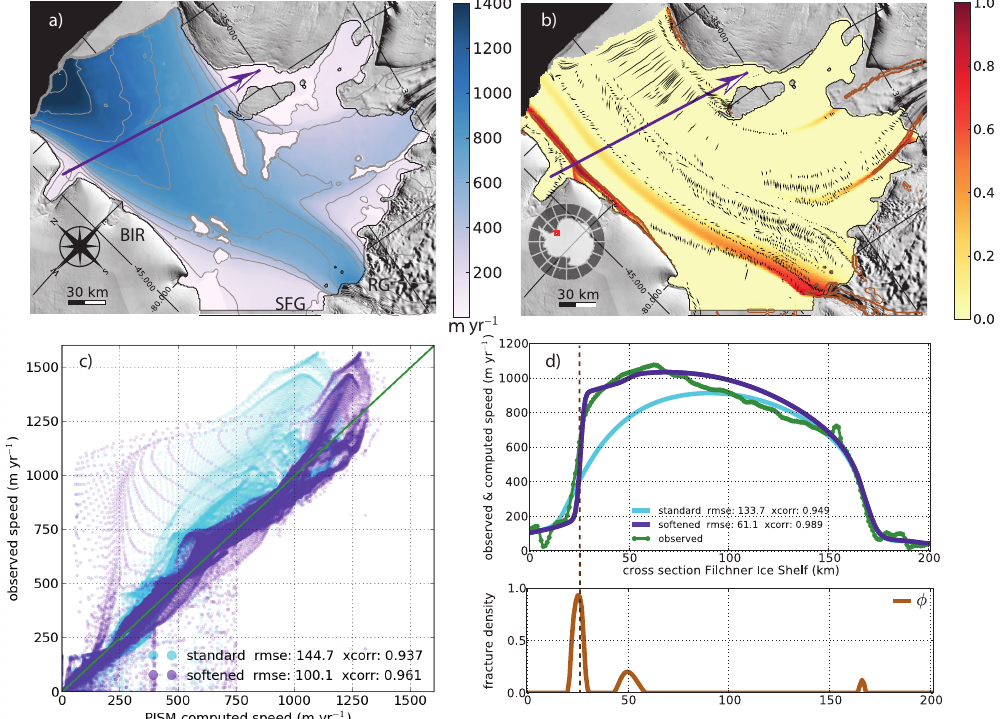
Fig. 10. Observed surface speed over MODIS data (a) and calculated fracture density (b) in the Filchner Ice Shelf (light blue box in Fig. 6b). Scatter plot of computed vs. observed velocities (c) for constant flow enhancement (blue) and in the fracture-softened case (violet). Corresponding cross sections of observed and calculated ice speed as well as fracture density are shown in the lower right panel (d) . Parameters: FESOM-melting factor 1.0, E SSA = 0 . 2, γ = 0 . 3, σ cr = 130kPa, γ h = 0 . 02, ˙ (cid:15) h = 15 × 10 − 10 s − 1